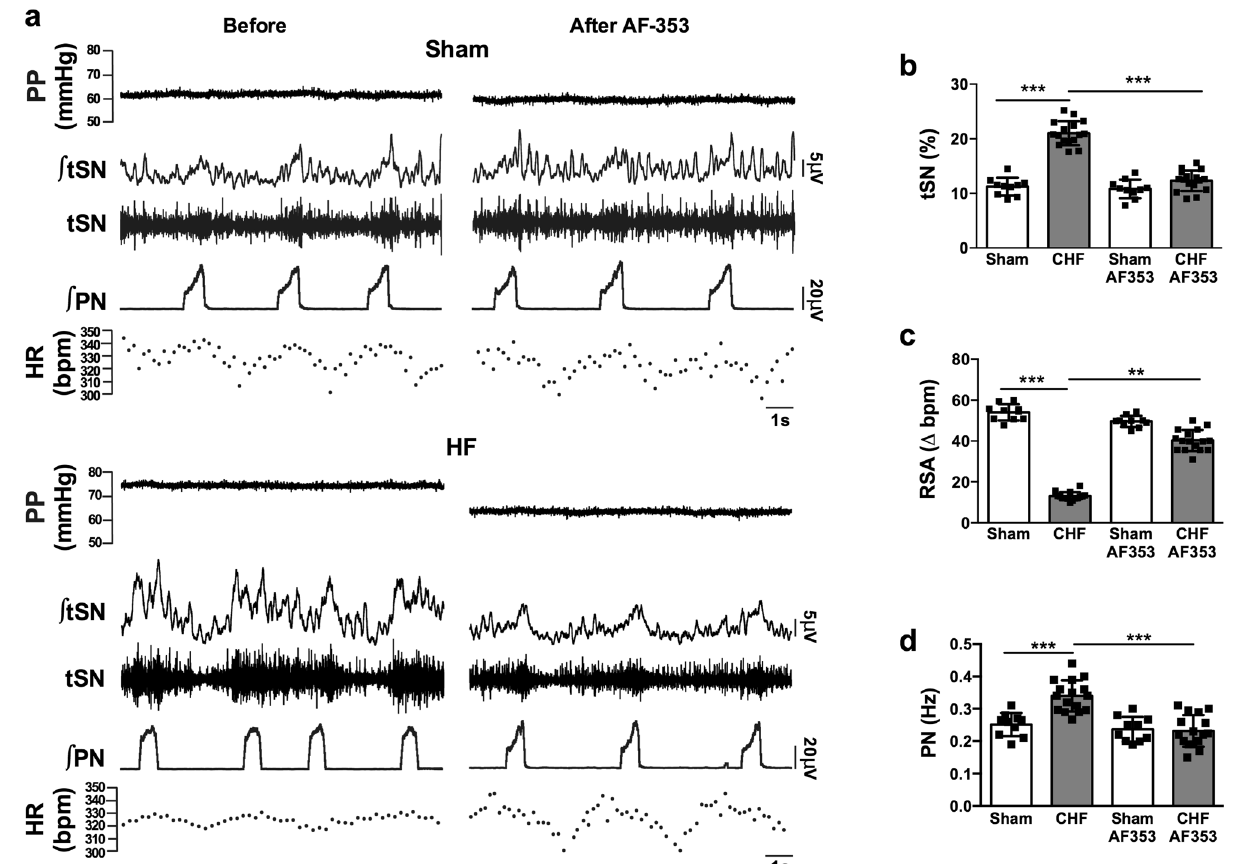
Fig. 3 | P2X3-receptor antagonism in heart failure (HF) rats is associated with restoring autonomic balance and respiratory activity in the in situ prepara- tion.a Raw( ∫ )andintegratedrecordsofthoracicsympathetic(tSN),phrenicnerve (PN), and heartrate (HR, bpm) insham and HFrats beforeand afterP2X3 receptor inhibition using AF-353. Note the drug was infused via a micropipette into the carotid bodies directly. In HF rats, there was increased activity of tSN and PN,